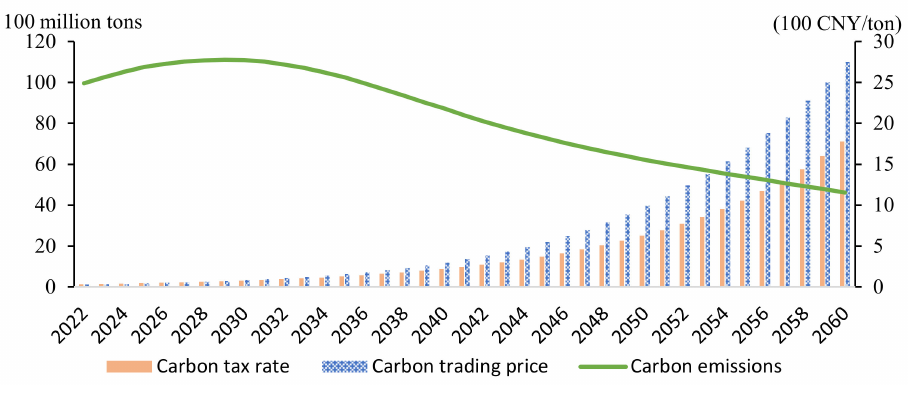
Figure 6. Carbon price and carbon